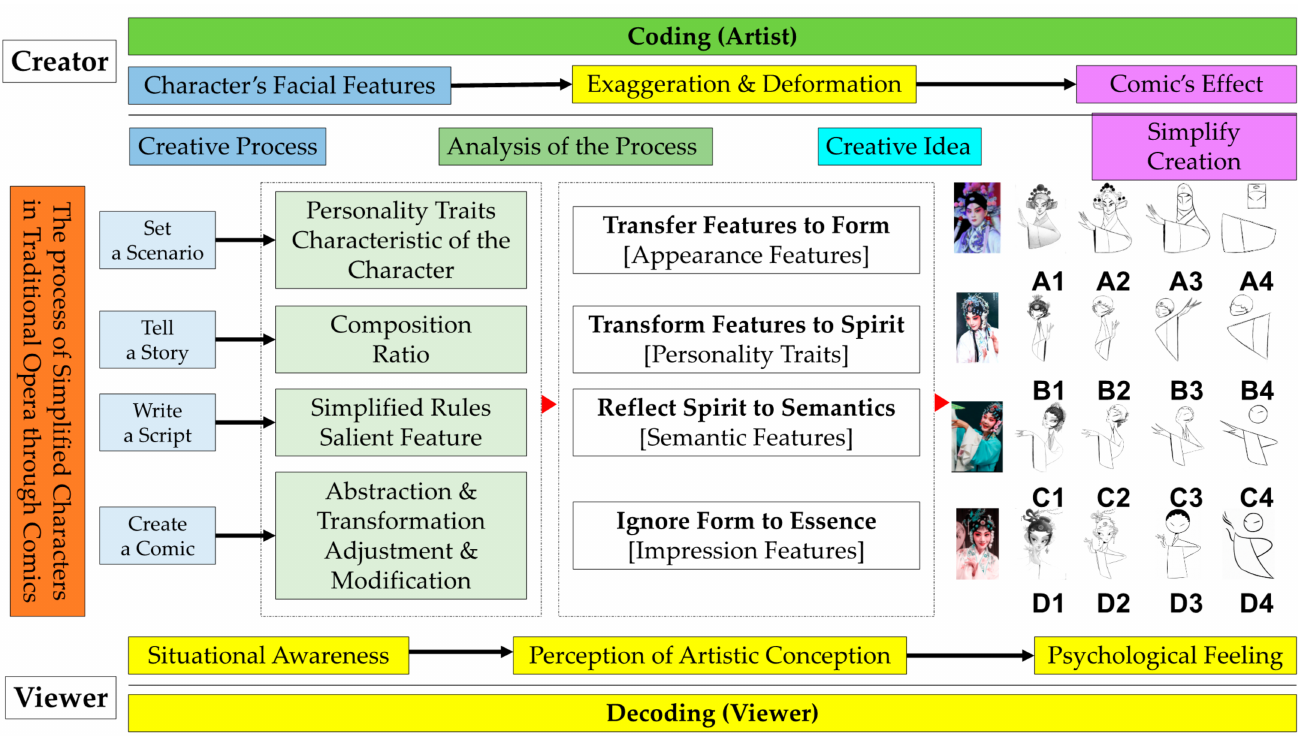
Figure 3. Research framework (Source: this